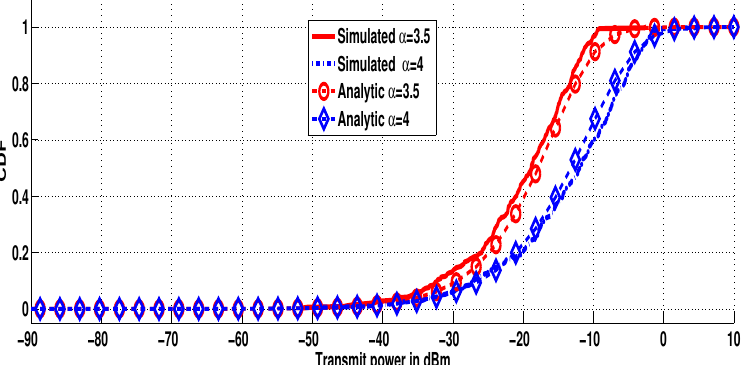
Figure 3. CDF of the transmit power for different values of α .